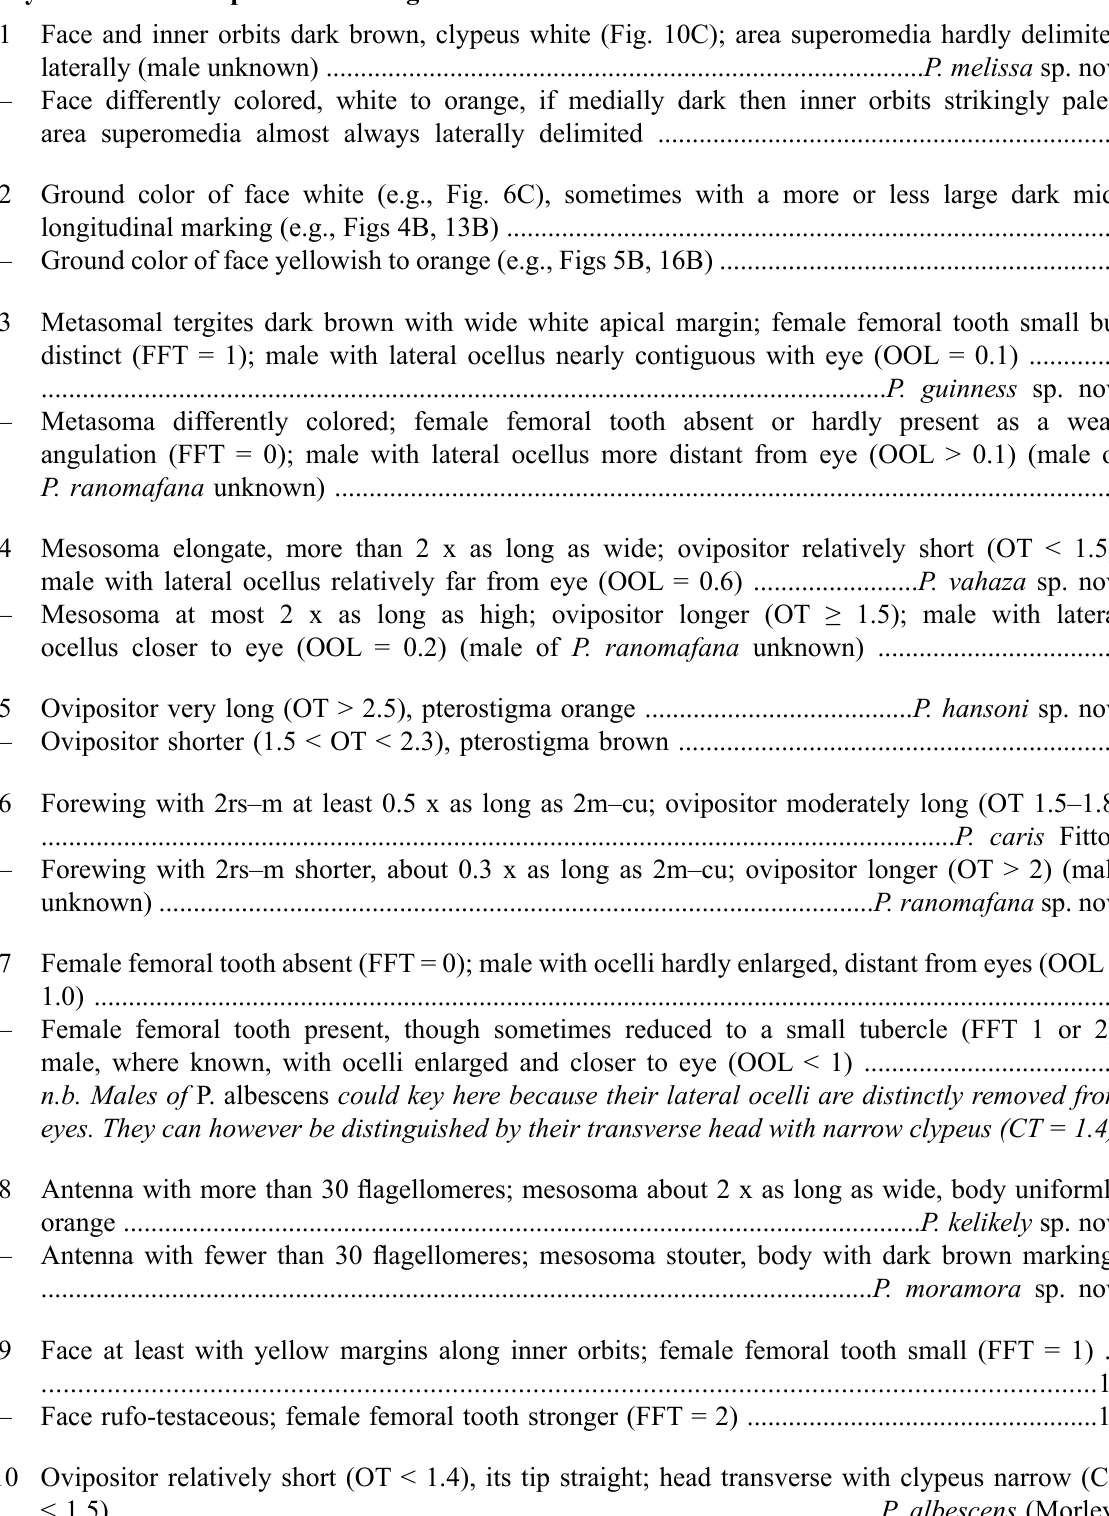
Key to Pristomerus species of Madagascar 1 Face and inner orbits dark brown, clypeus white (Fig. 10C); area superomedia hardly delimited laterally (male unknown) ....................................................................................... P. melissa sp. nov. – Face differently colored, white to orange, if medially dark then inner orbits strikingly paler; area superomedia almost always laterally delimited ..................................................................2 2 Ground color of face white (e.g., Fig. 6C), sometimes with a more or less large dark mid- longitudinal marking (e.g., Figs 4B, 13B) ........................................................................................3 – Ground color of face yellowish to orange (e.g., Figs 5B, 16B) .........................................................7 3 Metasomal tergites dark brown with wide white apical margin; female femoral tooth small but distinct (FFT = 1); male with lateral ocellus nearly contiguous with eye (OOL = 0.1) .............. – Metasoma differently colored; female femoral tooth absent or hardly present as a weak angulation (FFT = 0); male with lateral ocellus more distant from eye (OOL > 0.1) (male of P. ranomafana unknown) .................................................................................................................4 4 Mesosoma elongate, more than 2 x as long as wide; ovipositor relatively short (OT < 1.5); male with lateral ocellus relatively far from eye (OOL = 0.6) ........................ P. vahaza sp. nov. – Mesosoma at most 2 x as long as high; ovipositor longer (OT ≥ 1.5); male with lateral ocellus closer to eye (OOL = 0.2) (male of P. ranomafana unknown) ..................................5 5 Ovipositor very long (OT > 2.5), pterostigma orange ....................................... P. hansoni sp. nov. Ovipositor shorter (1.5 < OT < 2.3), pterostigma brown ...............................................................6 Forewing with 2rs–m at least 0.5 x as long as 2m–cu; ovipositor moderately long (OT 1.5–1.8) Forewing with 2rs–m shorter, about 0.3 x as long as 2m–cu; ovipositor longer (OT > 2) (male Female femoral tooth absent (FFT = 0); male with ocelli hardly enlarged, distant from eyes (OOL = Female femoral tooth present, though sometimes reduced to a small tubercle (FFT 1 or 2); male, where known, with ocelli enlarged and closer to eye (OOL < 1) ....................................9 n.b. Males of P. albescens could key here because their lateral ocelli are distinctly removed from eyes. They can however be distinguished by their transverse head with narrow clypeus (CT = 1.4). Antenna with more than 30 flagellomeres; mesosoma about 2 x as long as wide, body uniformly orange .................................................................................................................... P. kelikely sp. nov. – Antenna with fewer than 30 flagellomeres; mesosoma stouter, body with dark brown markings Face at least with yellow margins along inner orbits; female femoral tooth small (FFT = 1) ... – Face rufo-testaceous; female femoral tooth stronger (FFT = 2) ...................................................14 10 Ovipositor relatively short (OT < 1.4), its tip straight; head transverse with clypeus narrow (CT < 1.5) ............................................................................................................... P. albescens (Morley) – Ovipositor longer (OT 1.5–2.5), apically sinuate; head not distinctly transverse, clypeus more transverse (CT > 1.5)